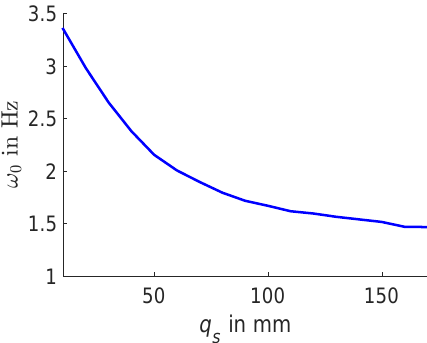
Figure 4. Mapping between active length and antiresonance frequency.